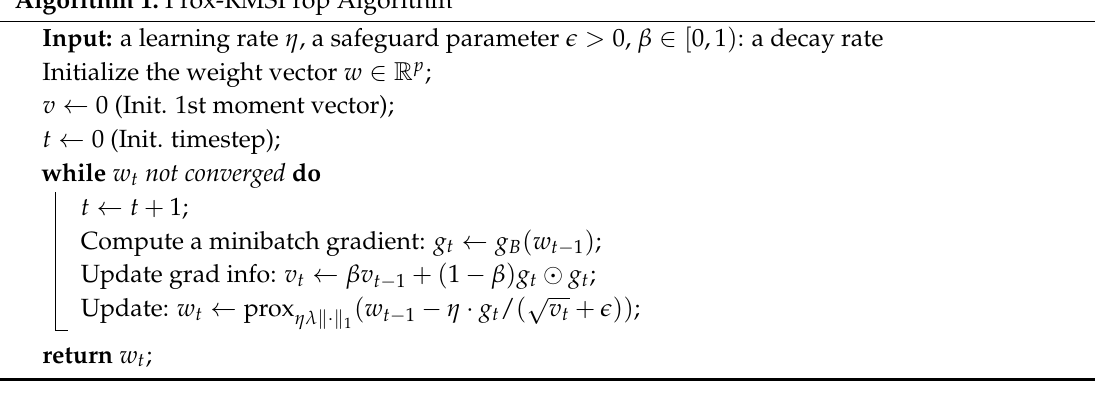
Algorithm 2. Prox-ADAM